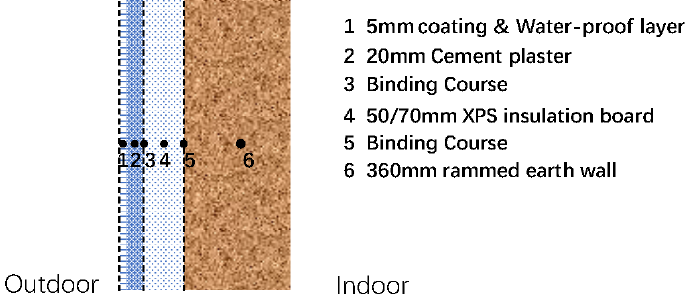
Figure 21. Schematic diagram of the composite RE wall construction.